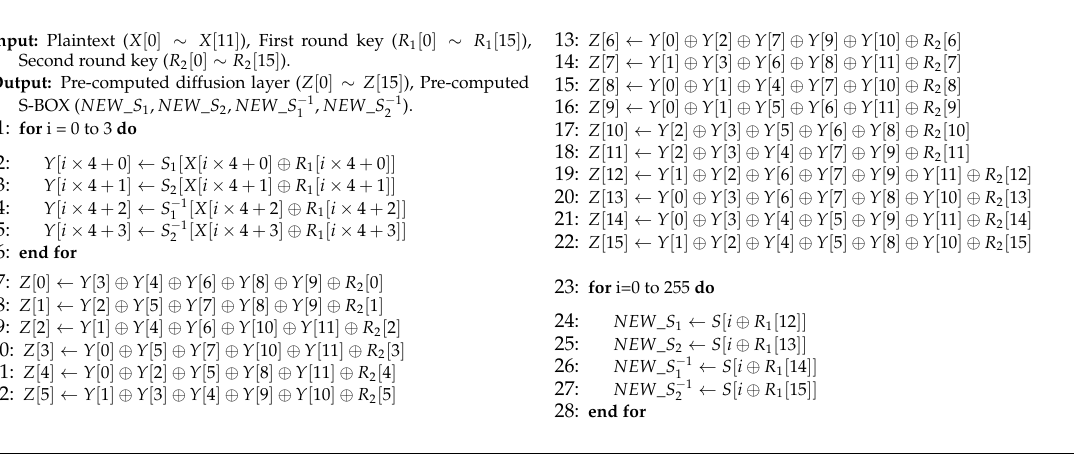
Algorithm 8 Offline: LUT computations for ARIA-CTR.